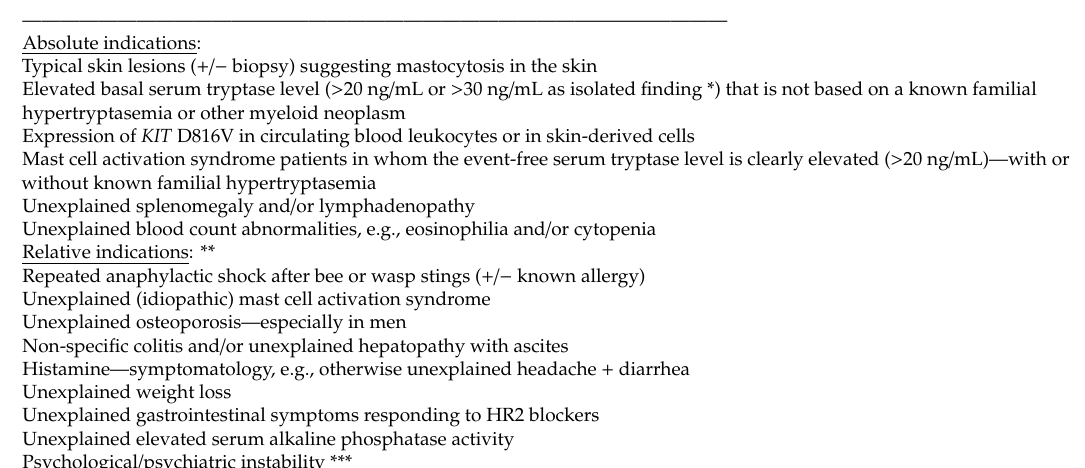
Table 1. Clinical and laboratory features that argue for a bone marrow examination in adult patients with suspected mast cell disease.